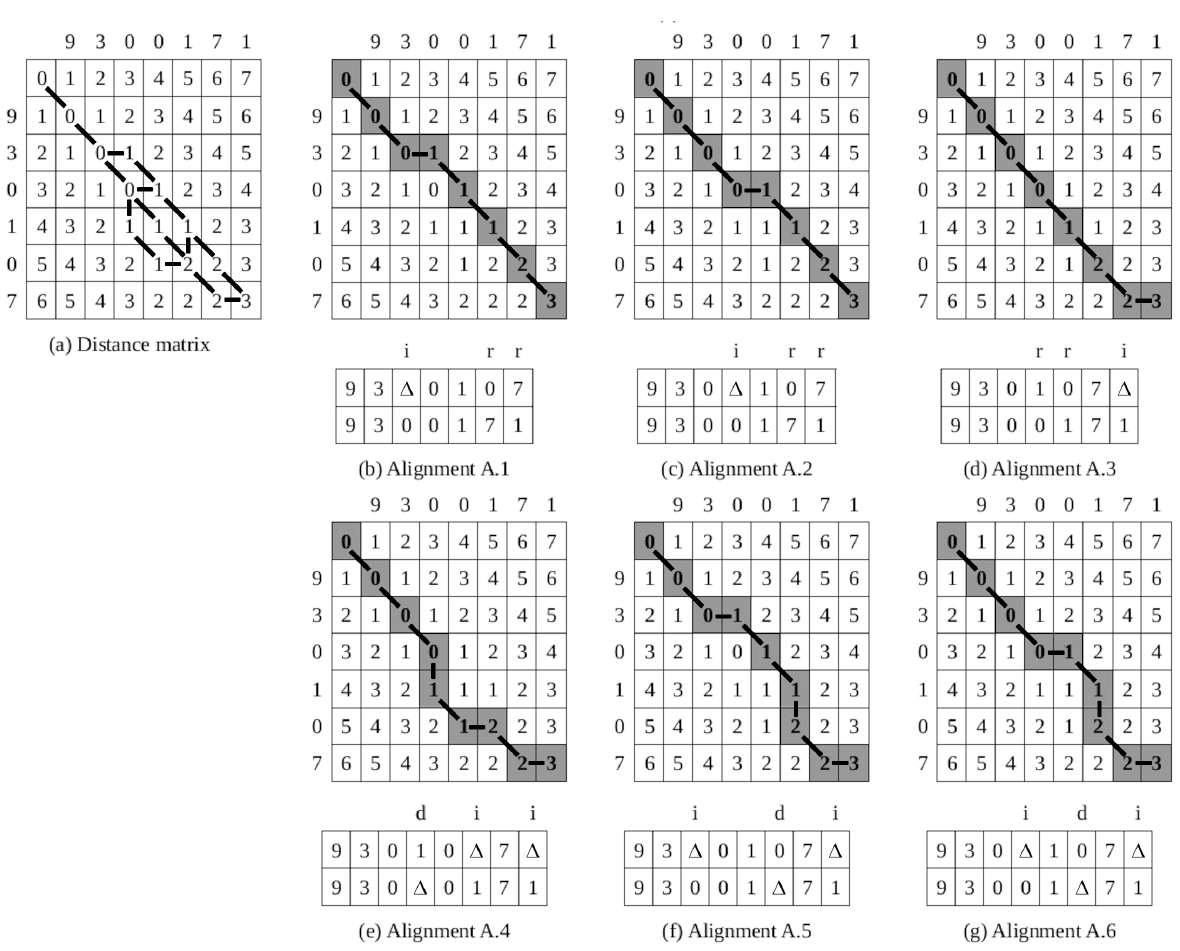
Figure 2. Illustration of the minimum edit distance algorithm. The costs of all single-symbol edit op- erations are equal to one, cf. Equation (8). Abbreviations: i—insertion, d—deletion,